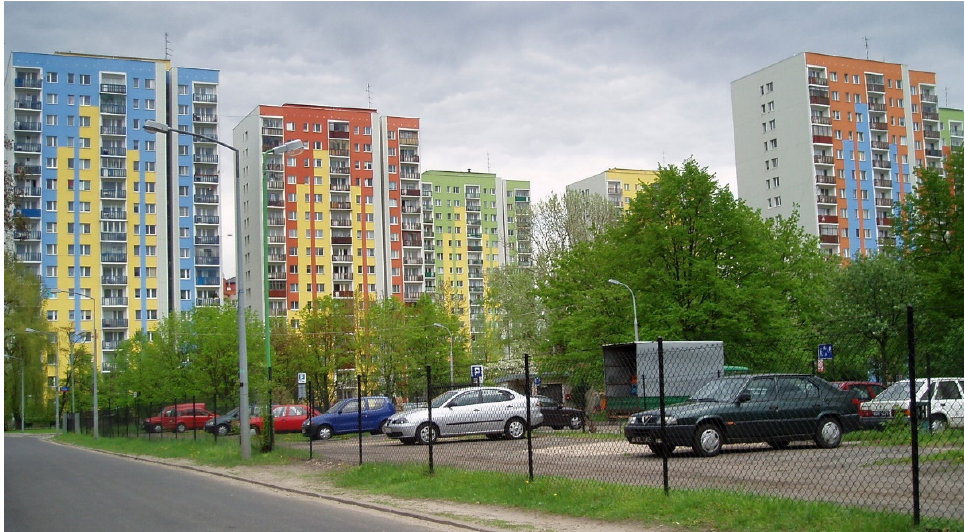
Figure 1. Renovation of prefabricated post-war housing estate in Warsaw © Cezary Piwowarski